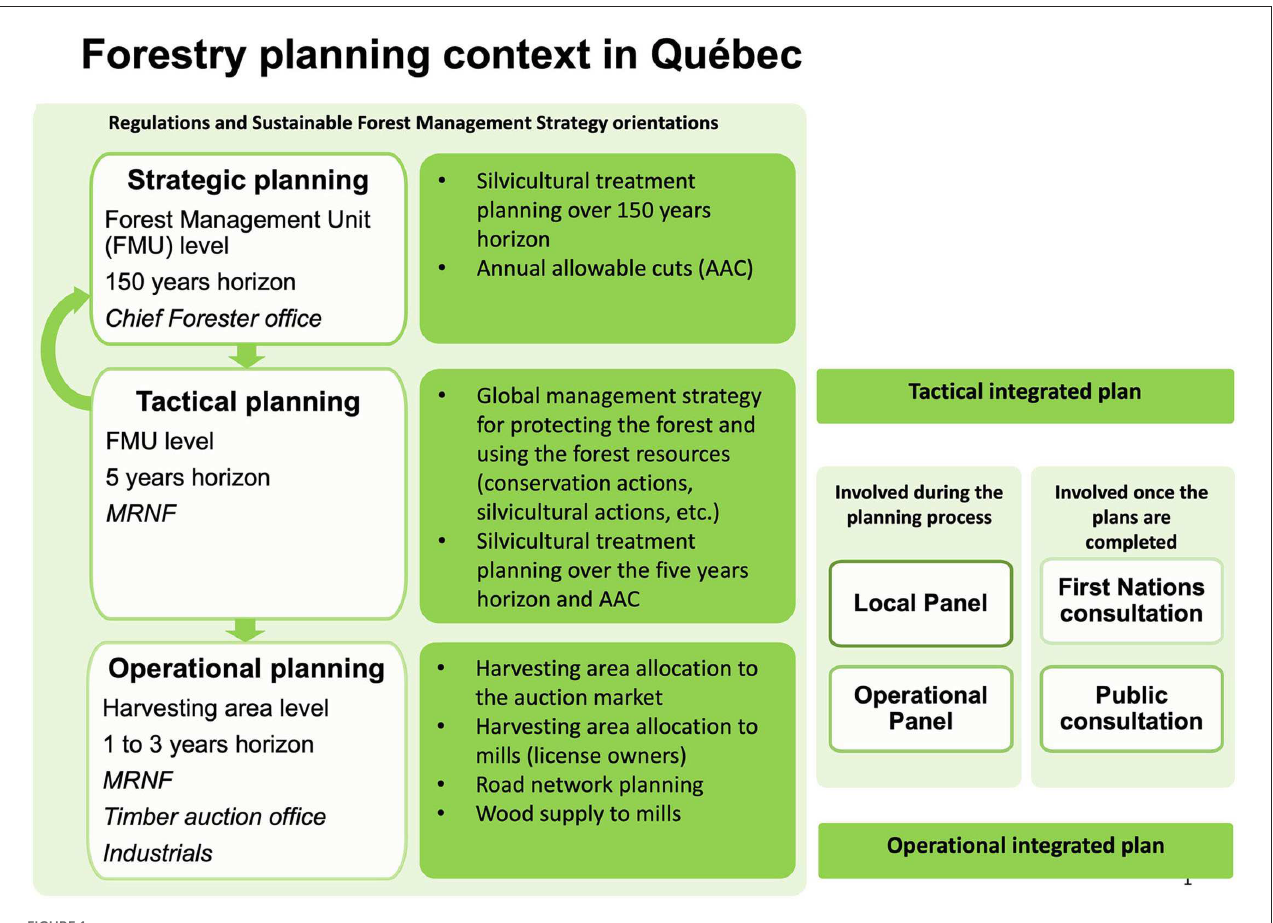
FIGURE1 Description of public-owned forest management in Quebec (Boukherroub et al., 2018).